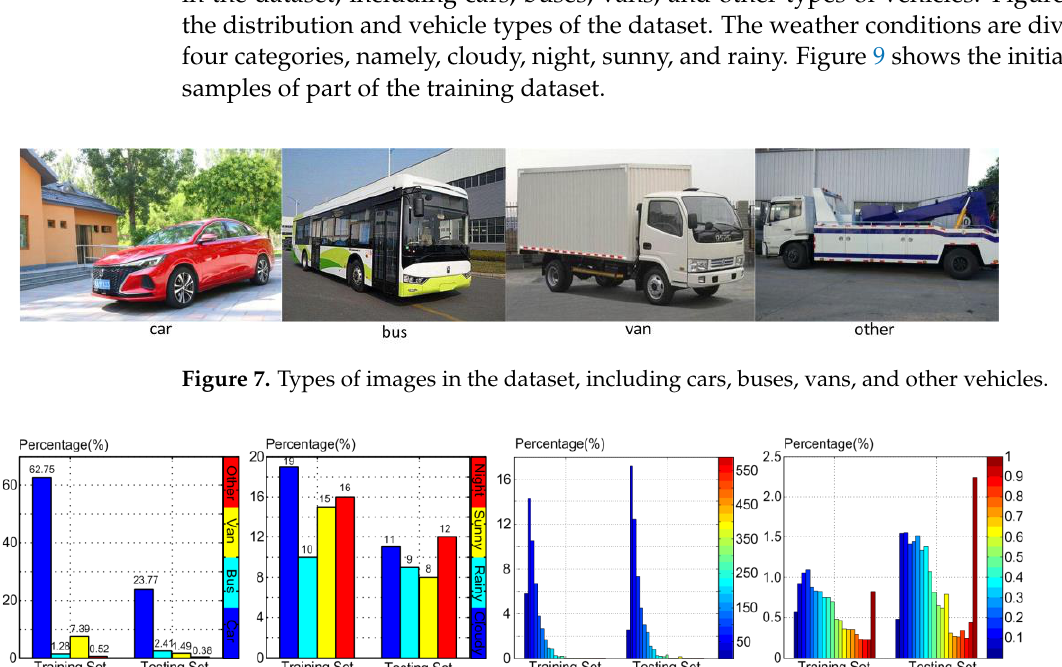
Figure 6. Feature schematic of the receptive field passing through the RFLA Gauss module. g stands for the Gaussian convolution kernel.